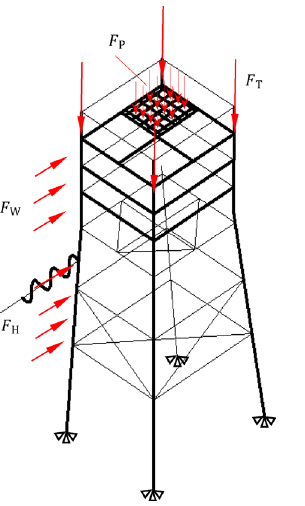
Fig. 2 Force diagram of the platform